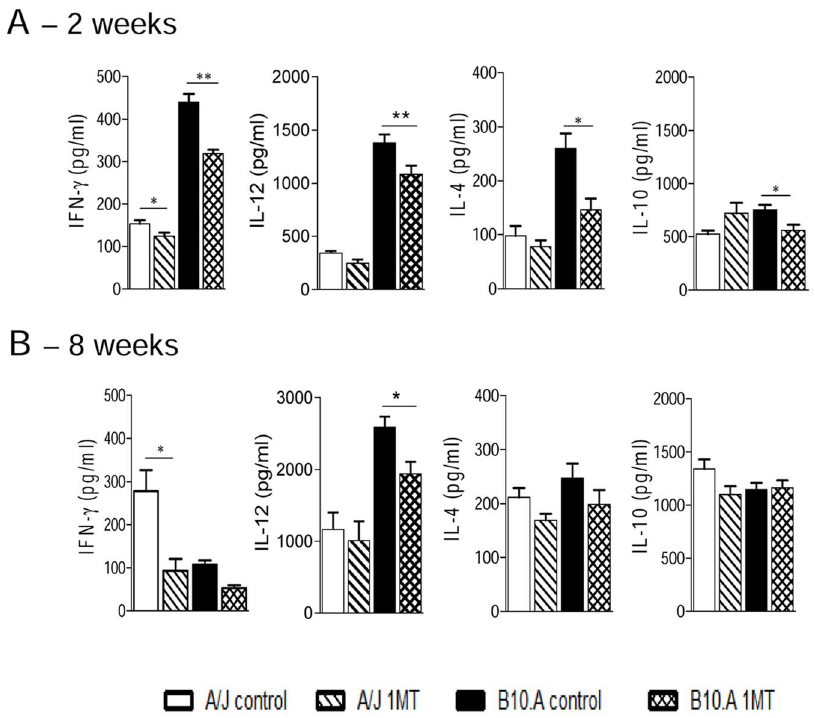
Figure 7. Levels of Th1/Th2 cytokines in the lungs of 1MT treated and untreated A/J and B10.A mice. ( A, B ) At week 2 and 8 after i.t. infection with 1 6 10 6 yeast cells of P. brasiliensis , lungs from 1MT treated and untreated A/J and B10.A mice were collected, disrupted in 5 ml of PBS and supernatants analyzed for Th1 and Th2 cytokines (IFN- c , IL-12, IL-4 and IL-10) by capture ELISA. The bars depict mean 6 SEM of cytokine levels (6–8 mice per group). The results are representative of three independent experiments (* p , 0.05 and ** p , 0.01).